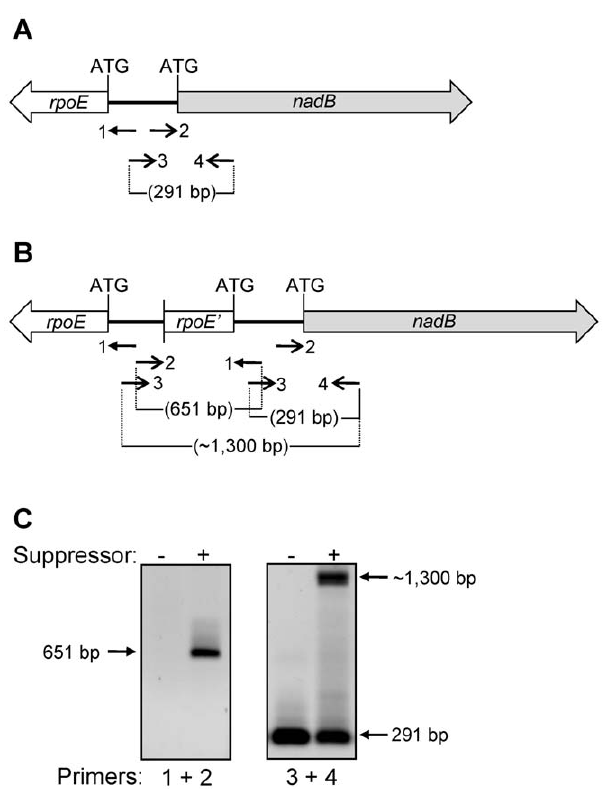
Figure 4. Identification of the genetic rearrangement in the suppressor strain. PCR amplifications were carried out to narrow down the site of possible genetic rearrangement in the rpoE - nadB region of the chromosome. ( A , B ) Approximate drawings showing the rpoE and nadB genes from the wild-type ( A ) and suppressor ( B ) strains, as well as the positions of primers (numbered 1 to 4), their orientations, and size of the amplified DNA fragments. ( C ) Agarose gels showing the results of PCR amplifications from the wild-type and suppressor strains. Numbers 1 to 4 refer to the primers shown in ( A ) and ( B ).